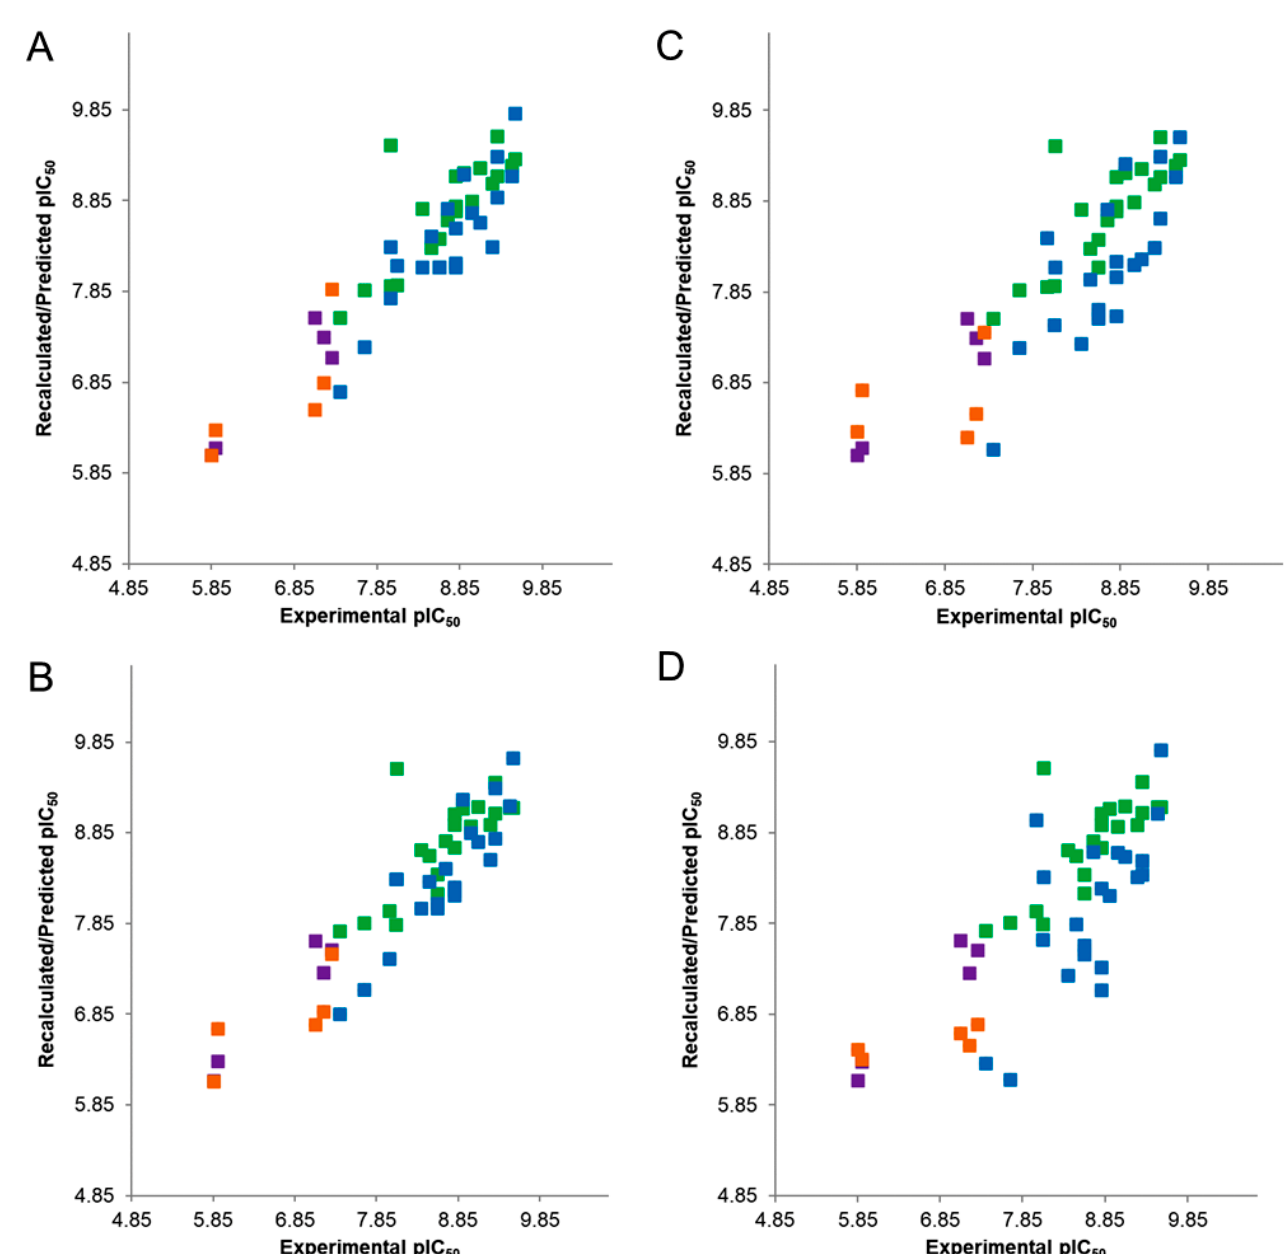
Figure 4. Experimental vs. recalculated (“actives”: green squares; “inactives”: purple squares) and predicted (“actives”: blue squares; “inactives”: orange squares) pIC 50 s for ADDHHHP.13 hypothesis and LOO cross-validation ( A ); ADDRRRP.11 hypothesis and LOO cross-validation ( B ); ADDHHHP.13 hypothesis and LSO cross-validation ( C ); ADDRRRP.11 hypothesis and LSO cross- validation ( D ).